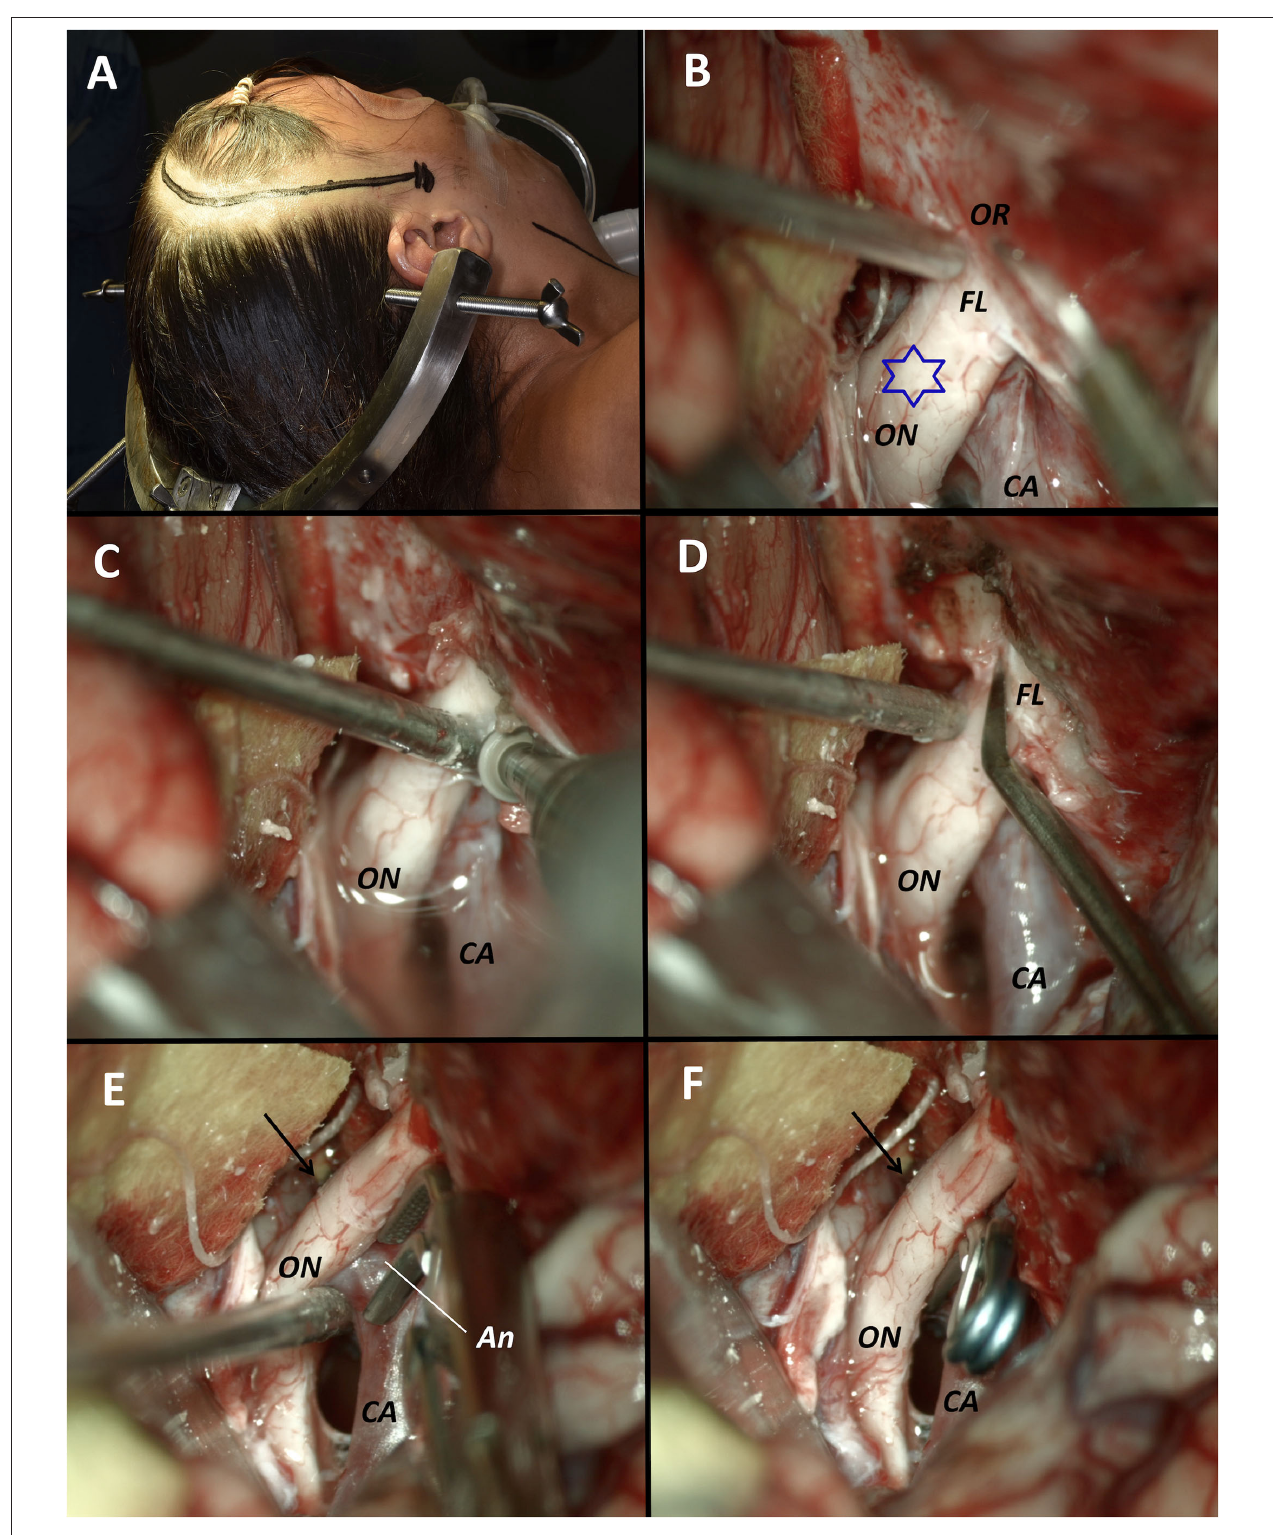
FIGURE 5 | Surgical images from Case 2. (A) Patient position in supine with the head fixed in a 4-pin Sugita head holder and a right curvilinear frontotemporal incision is marked behind the hair line. (B) Exposure of the optic nerve and the carotid artery where we can observe the optic canal roof and the falciform ligament. A circumferential incision of the dura above the optic canal was made with a blade N ◦ 11. The blue star marks the protrusion of the optic nerve due to the aneurysm.